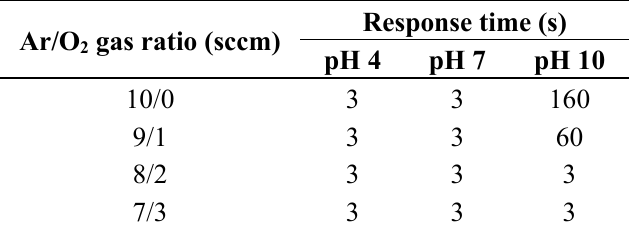
Table 2. Response time versus the Ar/O 2 ratios for different pH